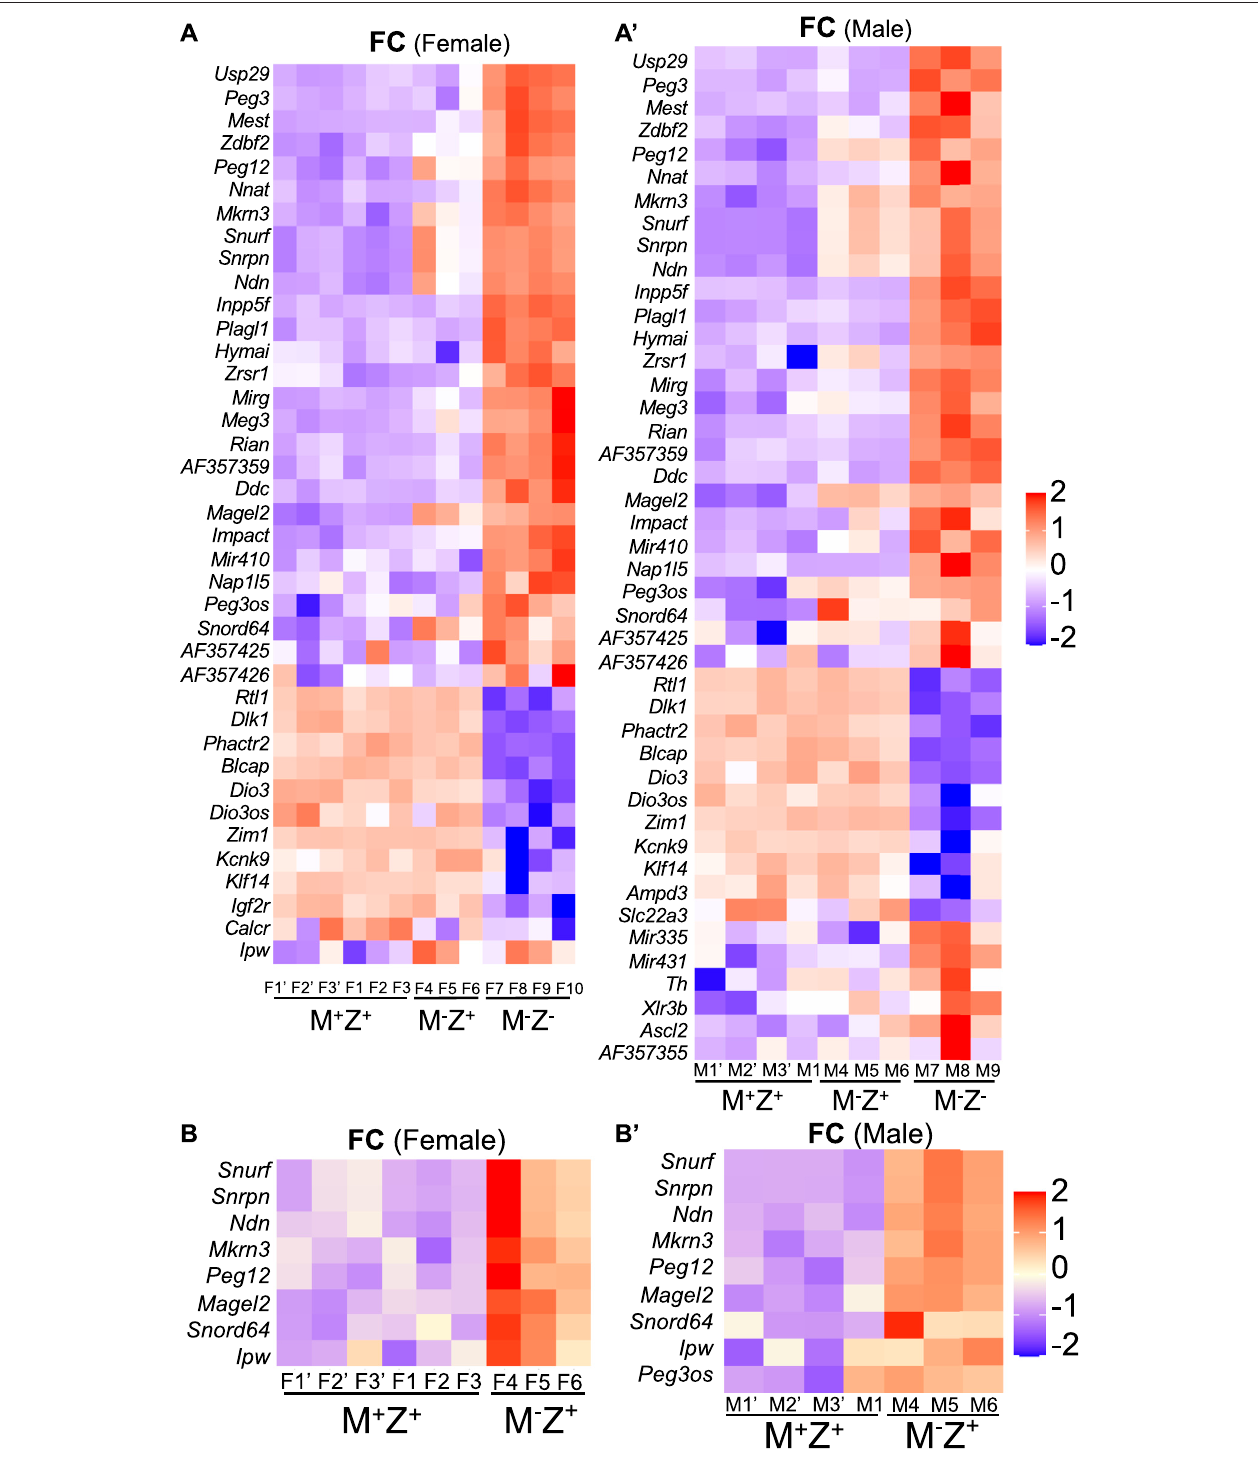
FIGURE8| Someimprintedgenesdisplayed sexually dimorphic effects in their expression in mouse embryos upon loss of Zfp57 or just maternal Zfp57 .RNA-seq analysiswasperformedforfemaleandmale129/DBAhybridembryosoftheM + Z + ,M − Z + ,andM − Z - genotypes.Thelog 2 FCvalueswereusedforquanti fi cationofthefold change (FC) of gene expression based on the ratios of TPM values for the imprinted gene transcripts in the M + Z + , M − Z + , and M − Z - embryos of the same gender. The imprintedgeneswithsigni fi cantdifferenceintheirexpressionlevelsabovethethreshold(|log